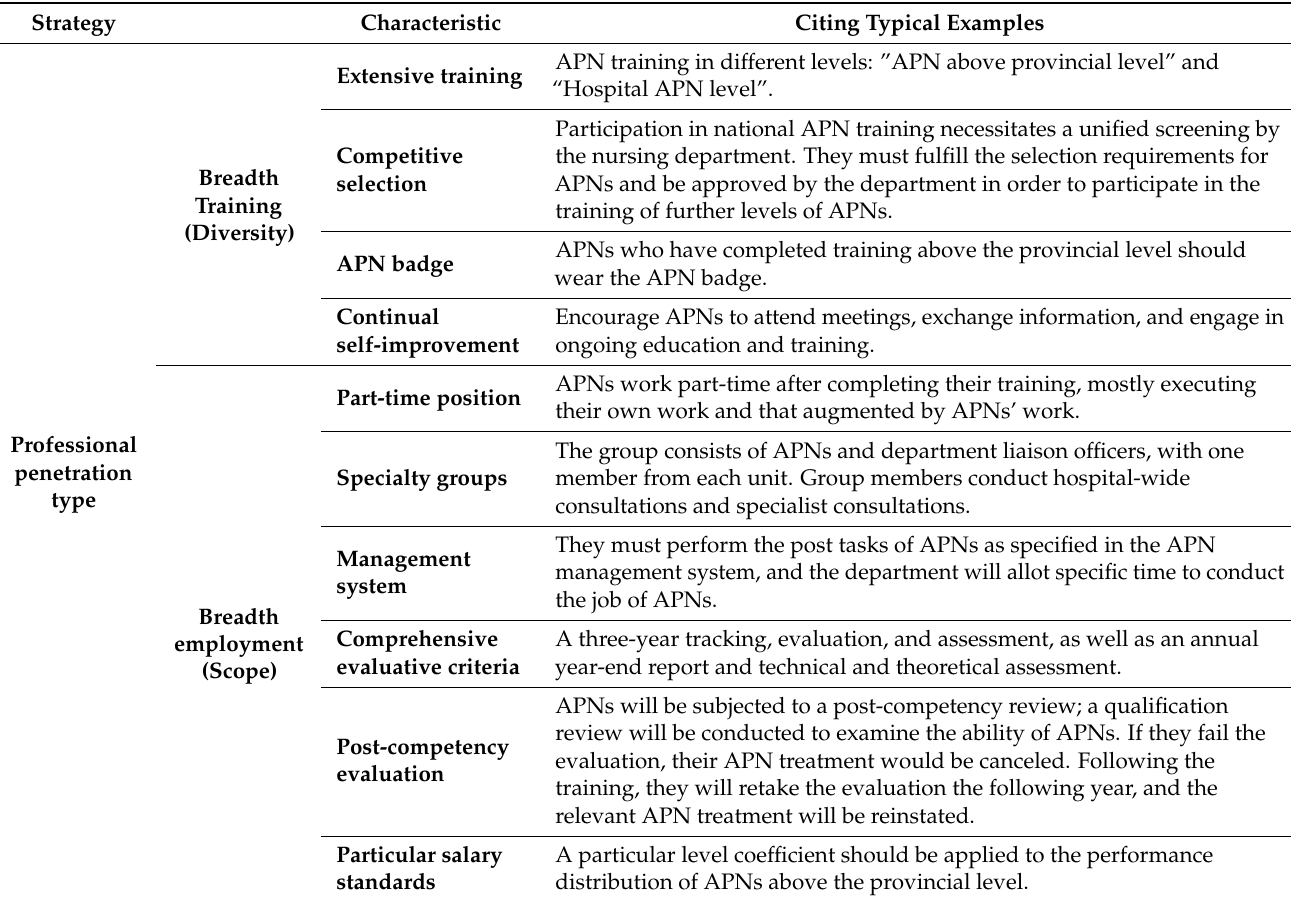
Table 7. Typical examples of management strategies of professional penetration